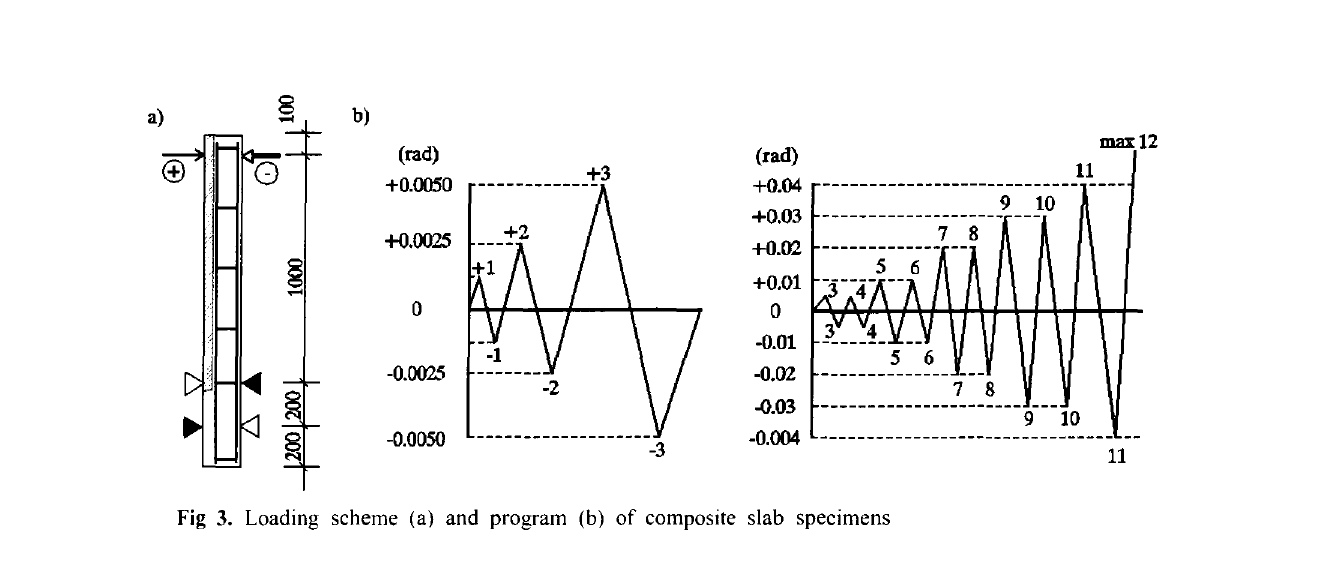
Fig 3. Loading scheme (a) and program (b) of composite slab